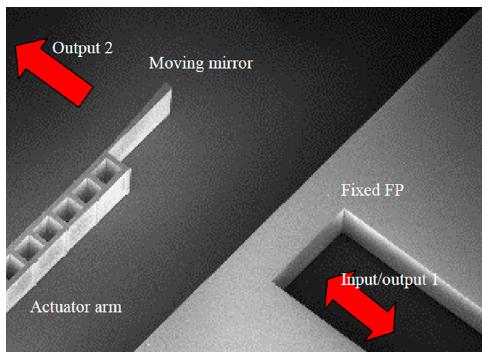
Figure 11. Cascaded FP interferometers based FTS. (Reprinted with permission from Reference [36] SPIE).